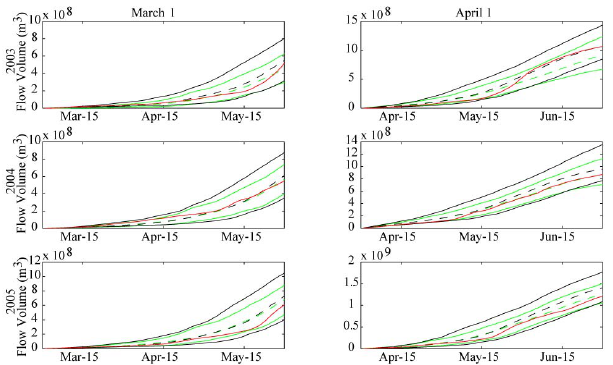
Fig. 8. The volumetric flow summed across 15 basins for each sea- sonal forecast following the specific forecast dates. The dashed line indicates the observed